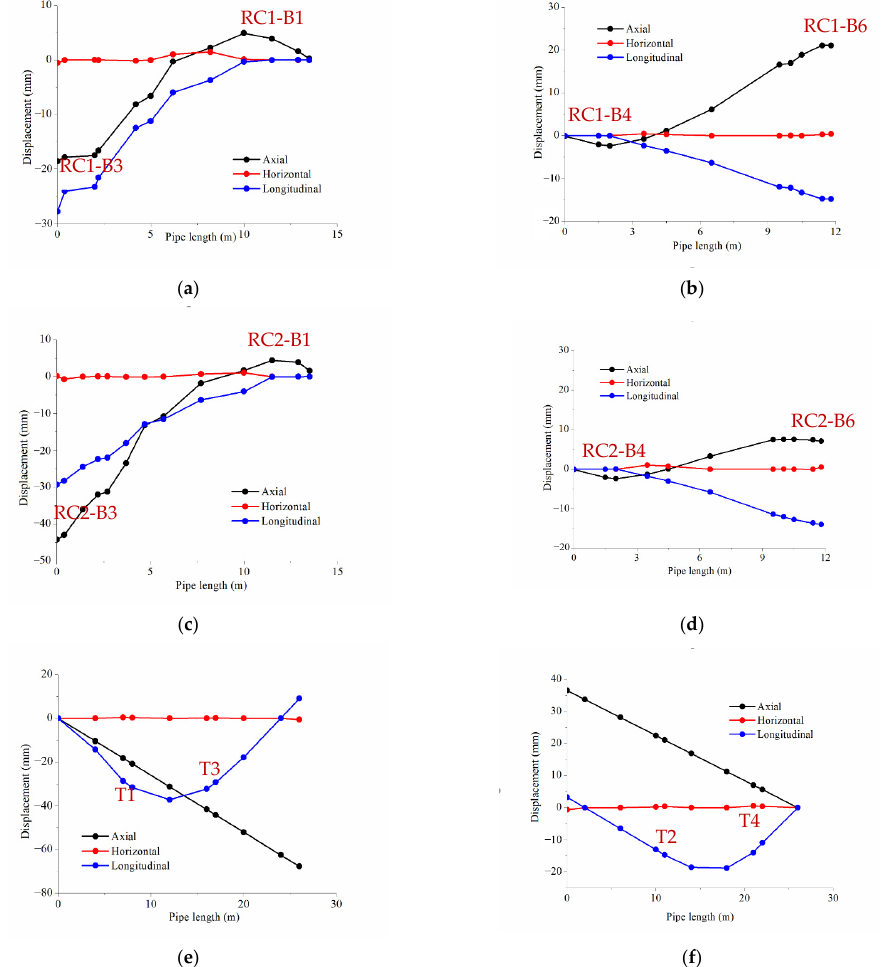
Figure 11. Displacement distribution: ( a ) Compressor (RC1) inlet pipe; ( b ) Compressor (RC1) outlet pipe; ( c ) Compressor (RC2) inlet pipe; ( d ) Compressor (RC2) outlet pipe; ( e ) Main suction pipe; ( f ) Main exhaust